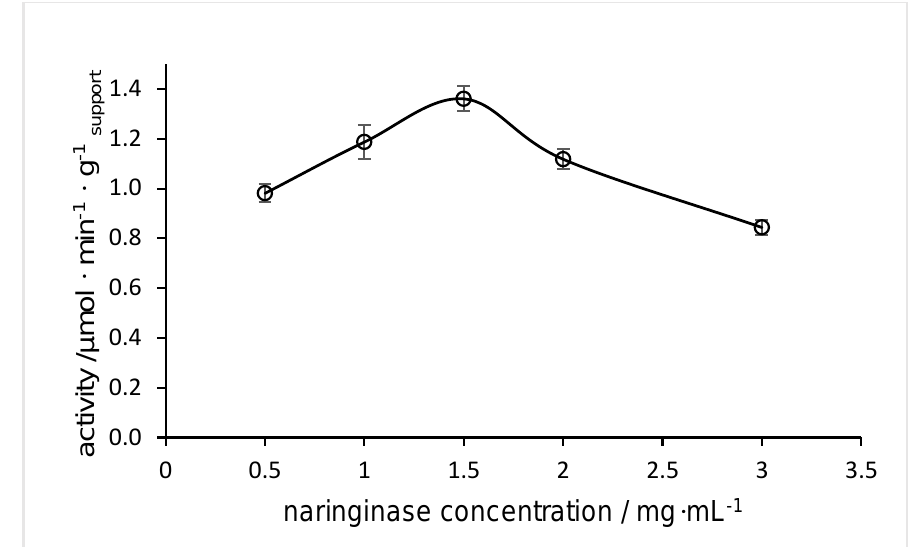
Figure 1. Effect of naringinase concentration on immobilization efficiency. Figure 1. E ff ect of naringinase concentration on immobilization e ffi